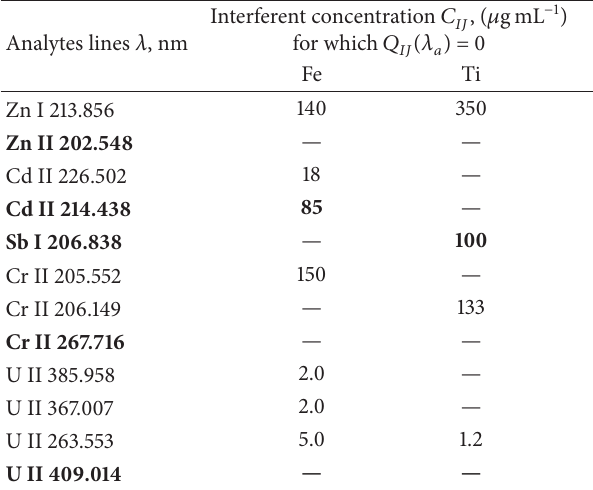
Table 3: Interferent concentration 𝐶 𝐼𝐽 ( 𝜇 gmL − 1 ) for which [ 𝑄 𝐼𝐽 ( 𝜆 𝑎 ) = 0] in the presence of Fe or Ti as interferents for the elements: Zn, Cd, Sb, Cr, and